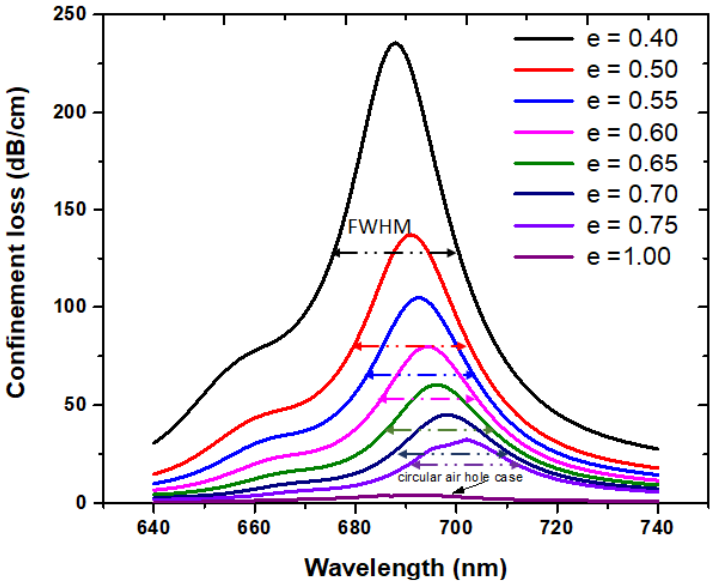
Figure 8. Confinement loss spectra of the core-guided mode for ellipticity ( e = 0.40, 0.50, 0.55, 0.60, 0.65, 0.70, 0.75, and 1.00).